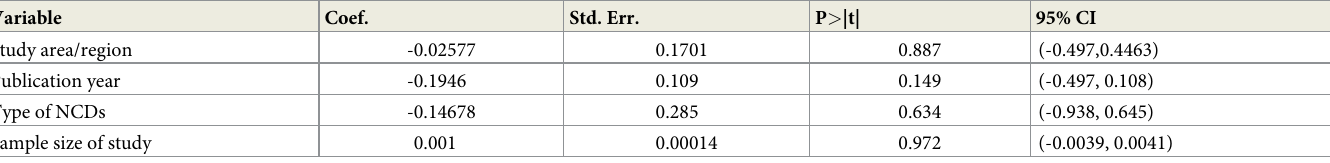
Table 3. Meta-regression analysis for the included studies to identify the source(s) of heterogeneity.